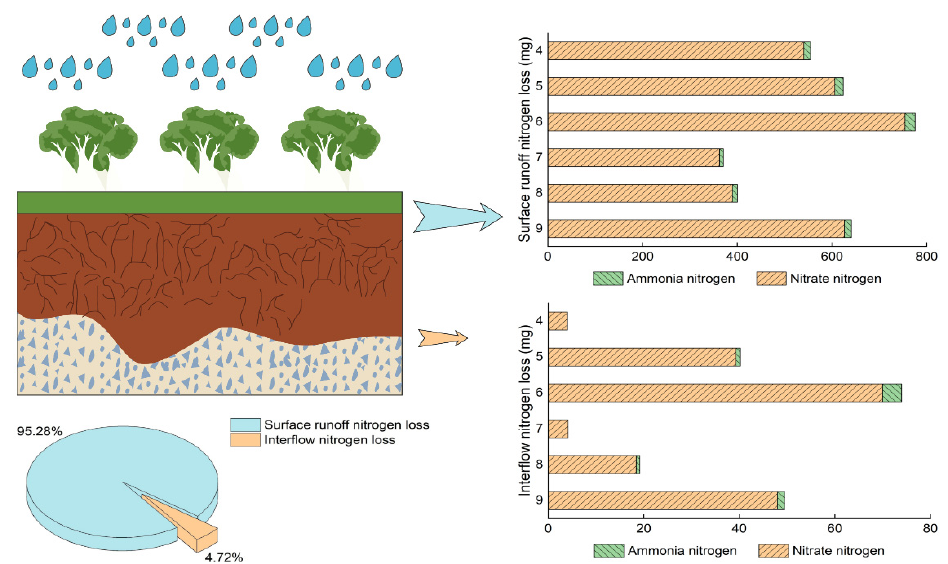
Figure 4. The amount of ammonia nitrogen (AN) and nitrate nitrogen (NN) loss, and the proportion of nitrogen loss in surface runoff and interflow.